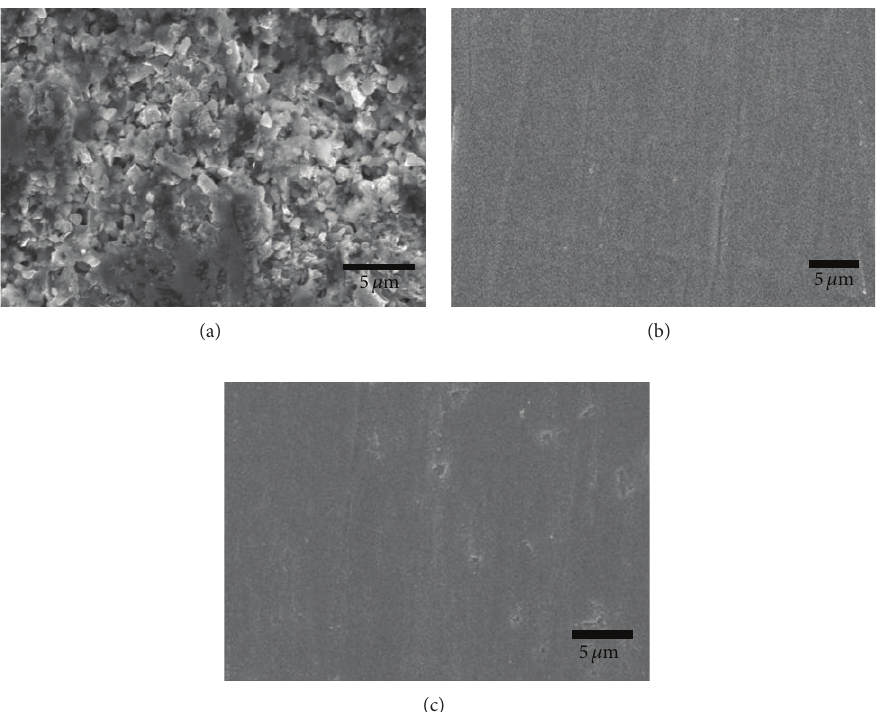
Figure 4: SEM micrographs of the cross-sections of consolidated Ti 5 Si 3 compacts obtained by (a) hot-pressing at 1200 ∘ C in a vacuum of 2 × 10 −6 torr for two hours with a pressure of 10 tons and electrical discharge consolidation using (b) 7.0kJ and (c) 8.0 kJ of input energy.